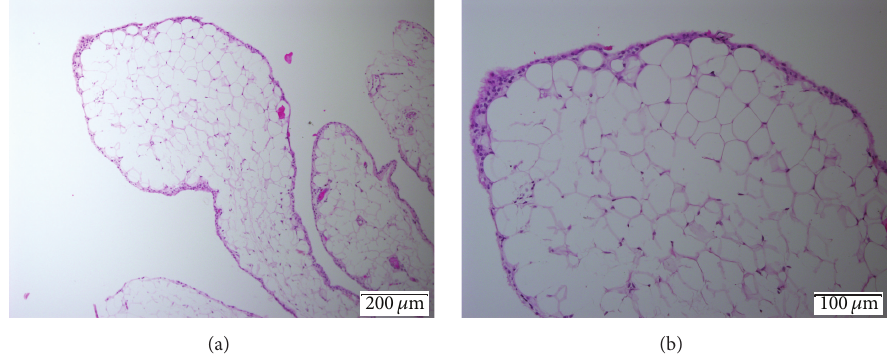
Figure 3: Histopathological photomicrographs. Hematoxylin and eosin stained sections of samples obtained from the glenohumeral joint during arthroscopy showing synovial lined villous proliferation which is diffusely infiltrated by mature fat cells while the periphery is lined by hypertrophic synovial cells and infiltrated by chronic inflammatory cells (bar size at lower right corner of images indicates 200 𝜇 m panel (a) and 100 𝜇 m panel